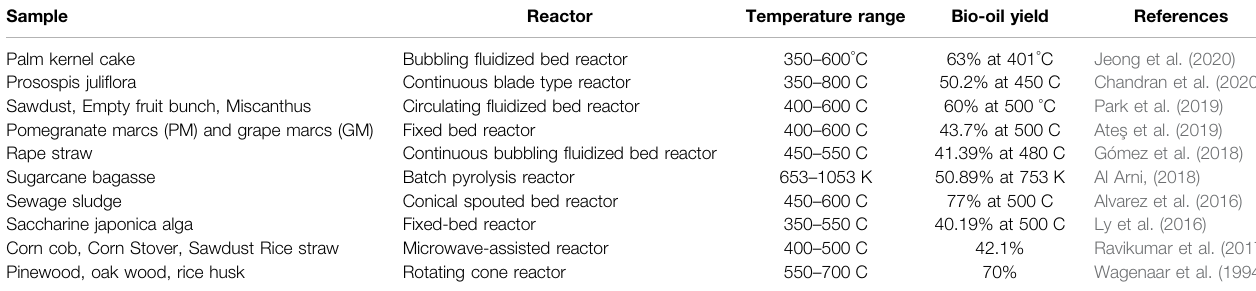
TABLE 1 | Experimental work on the fast pyrolysis of biomass for bio-oil production.